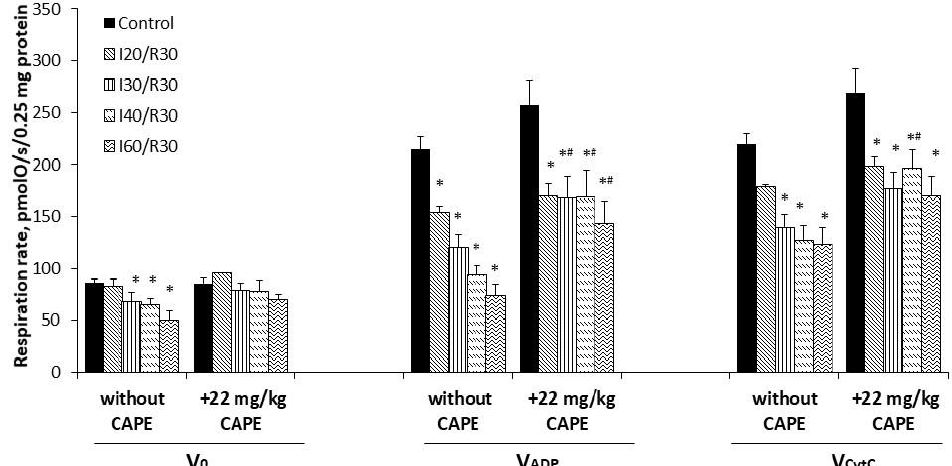
Figure 3. Effect of ischemia/reperfusion and CAPE on mitochondrial routine and state 3 respiration rate with glutamate/malate as substrates. Mitochondrial respiration rate was measured, as described in the Materials and Methods section, using 5 mM glutamate + 5 mM malate as substrates. V 0 —routine respiration rate in the presence of 0.25 mg/mL of the mitochondria and substrates; V ADP —state 3 respiration rate in the presence of 1 mM ADP; V CytC —state 3 respiration rate in the presence of 32 µ M cytochrome c; * p < 0.05 vs. the respective control; # p < 0.05 vs. ischemia/reperfusion without CAPE. One-way ANOVA followed by a Fisher’s LSD post hoc test were used to compare the effects.